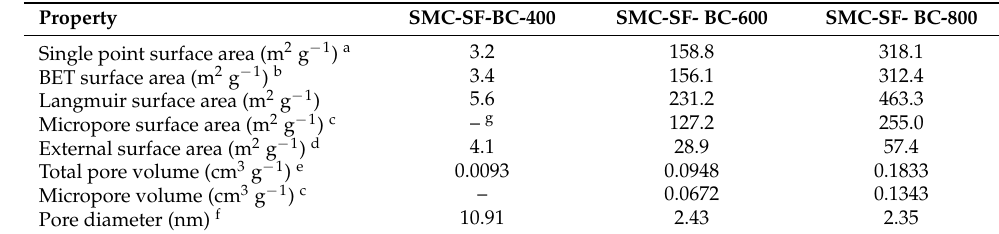
Table 2. Pore properties of biochar (BC) products prepared from SMC-SF at 400–800 ◦ C. Property